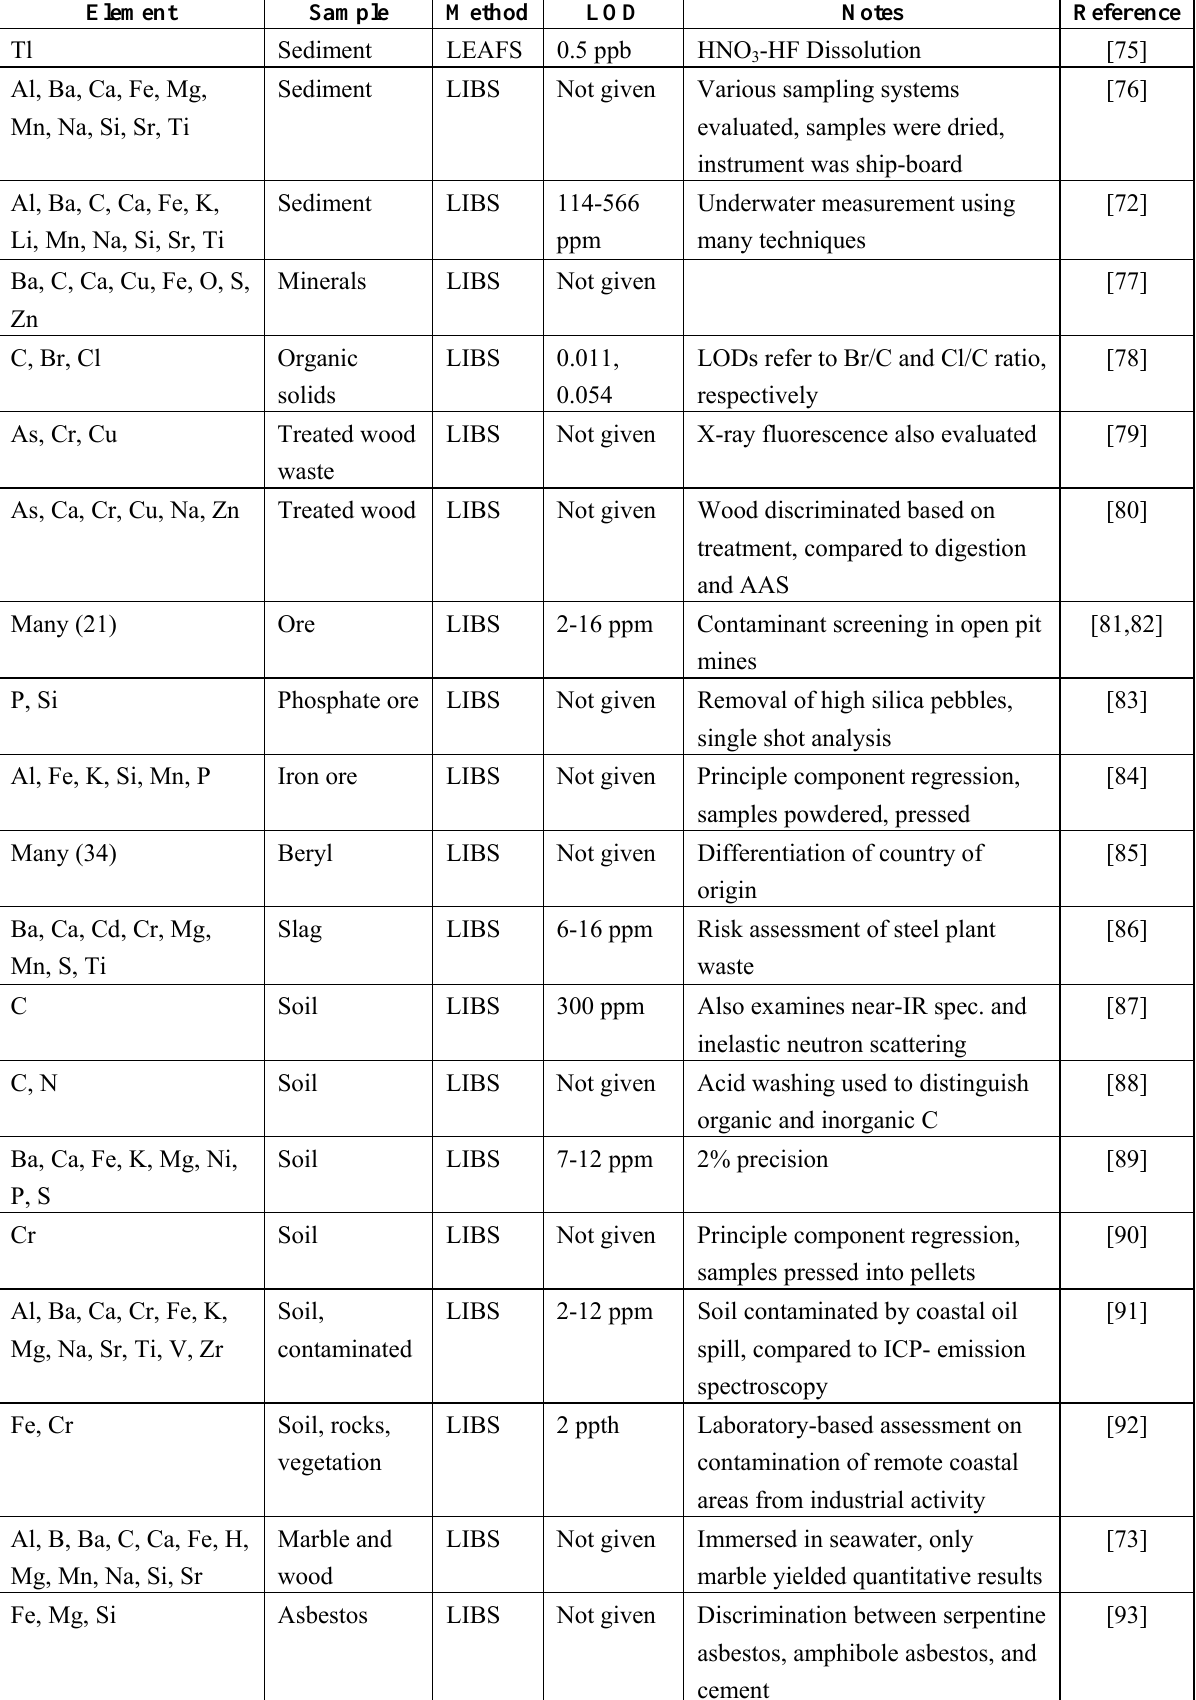
Table 1. Laser-based spectroscopic applications to environmental